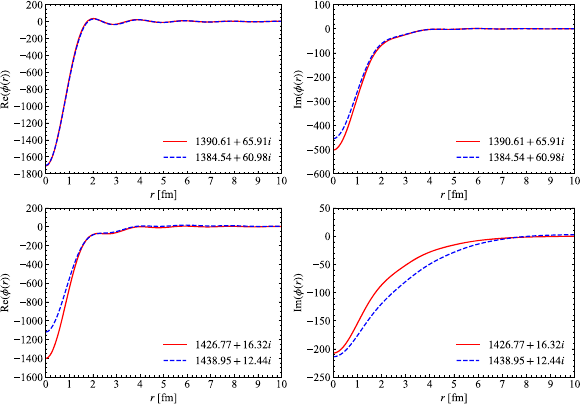
Fig. 7 Wave functions of two poles for the ¯ K N channel